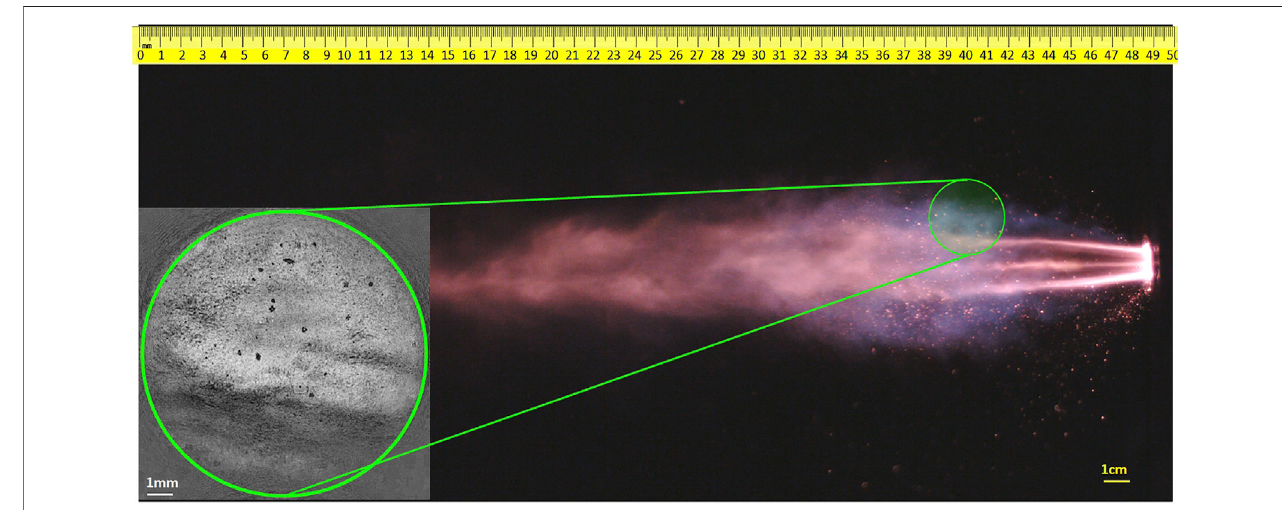
FIGURE 2 | Typical image results of SRM plume fi